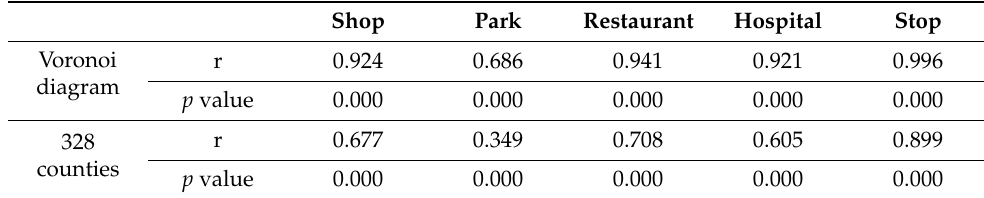
Table 1. Pearson correlation coefficient and p value between POI and the elderly cardholders in Voronoi diagram and 328 counties.